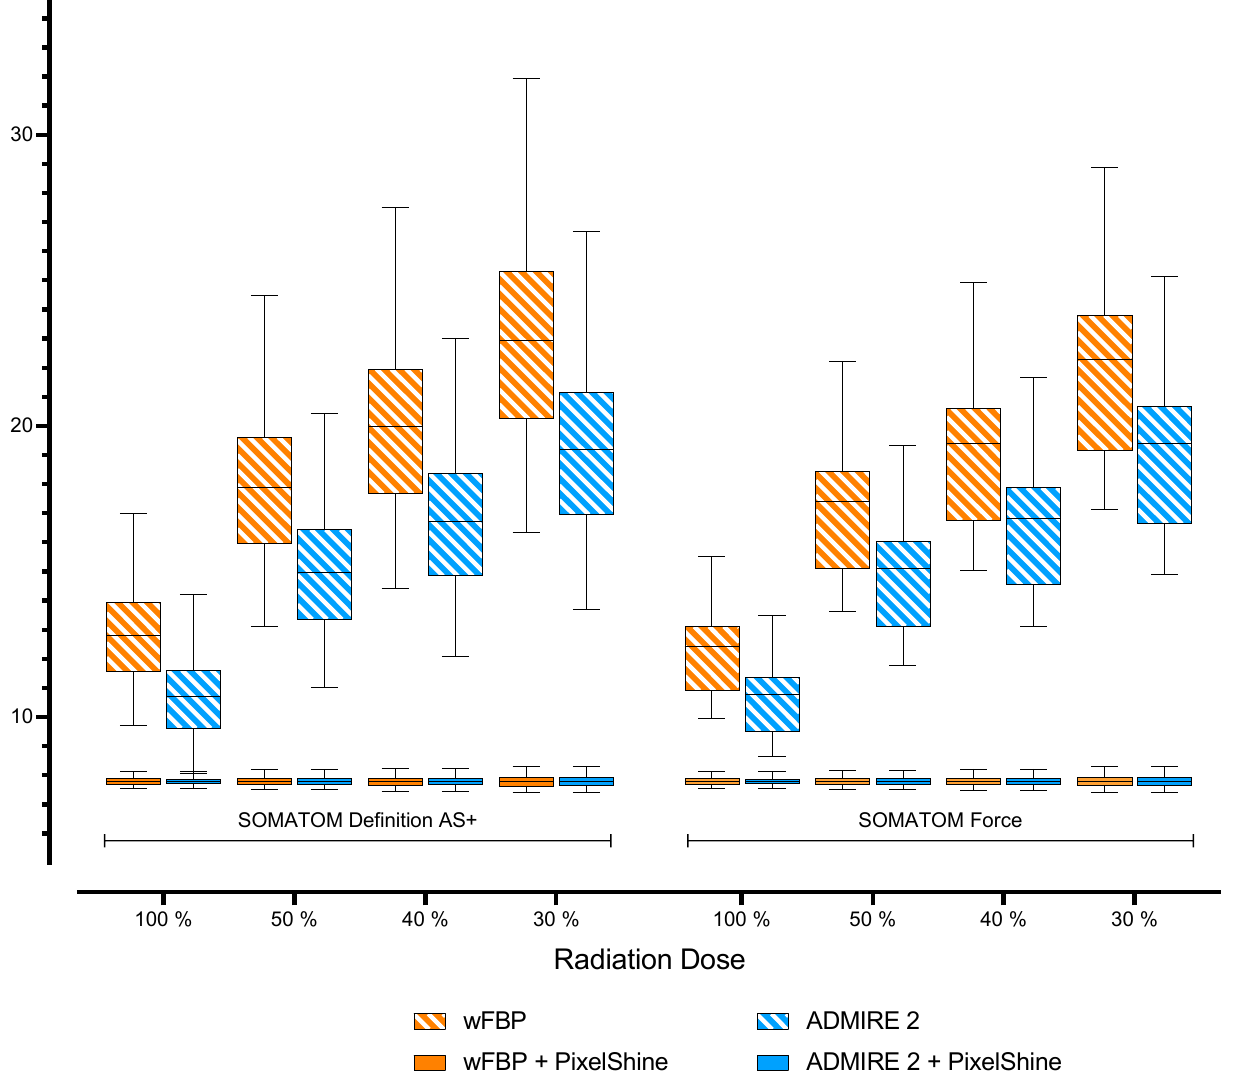
Figure 4. Visualization of mean noise levels. wFBP = weighted Filtered Back Projection, ADMIRE 2 = Advanced Modeled Iterative Reconstruction strength 2. Figure 5 visualizes image quality aspects in the setting of a hepatic melanoma metastasis (marked with red arrows) in a 54-year-old woman at different radiation dose levels using conventional reconstruction methods (top row) and post-processing (bottom row). Note the highly enhanced image quality in the post-processed images, facilitating diagnostic assessment as low as 30% of the initial radiation dose.